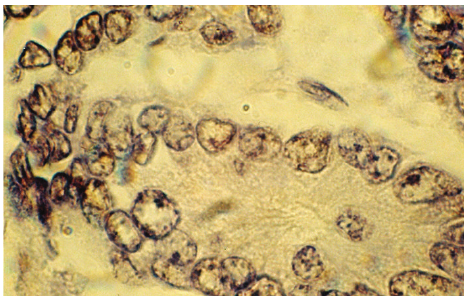
Figure 5: Unusual expression and cell compartmentalization of p53 protein in breast carcinoma cells. By immunohistochemical staining, p53 appears as discrete dot-shaped regions within the nucleus of the cell. p53 cancer-associated mutants localize to distinct domains in the nucleoli and at and around the nuclear membrane. The antibody reacted with a distinct perinuclear structure in almost all of the cells. Cytoplasmic p53 was observed as faint staining. Smaller tumor cell nuclei showed ball-like shape (frozen section, immunoperoxidase with antibody DO-7, nuclear counterstain with haematoxylin, ×